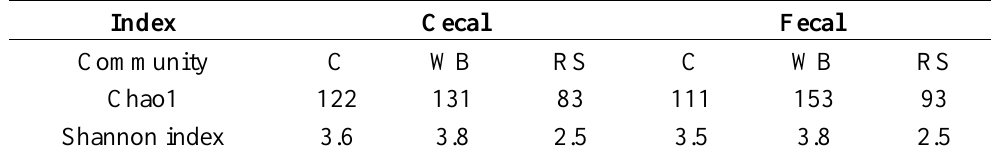
Table 2. Community richness (Chao1) and diversity (Shannon index) for cecal and fecal samples from rats fed each diet, calculated using FAST Group II software